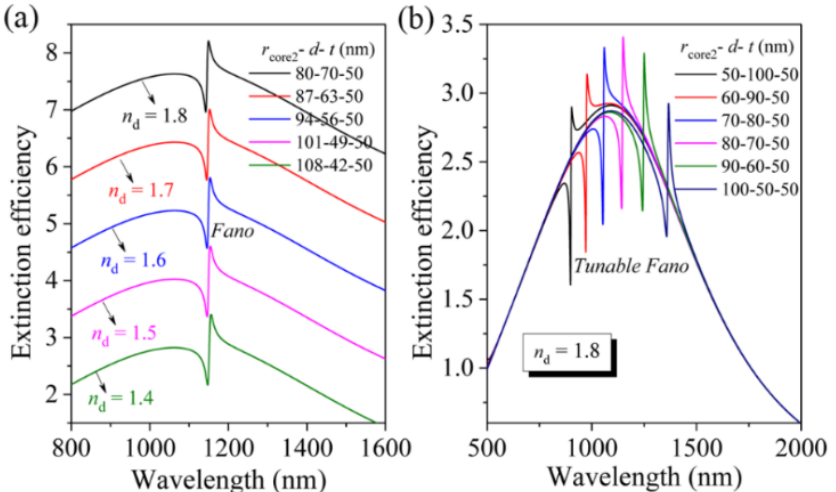
Figure 6. Tunable FR in the Ag nanomatryushka. ( a ) Calculated extinction efficiency spectra ( a 1 ) for an Ag nanomatryushka with different r core2 , n d and d (other parameters: r core2 + d = 150 nm) (each spectrum vertically offset by 1.2 for clarity). ( b ) Calculated extinction efficiency spectra ( a 1 ) for an Ag nanomatryushka with different r core2 and d (other parameters: n d = 1.8, and r core2 + d = 150 nm).